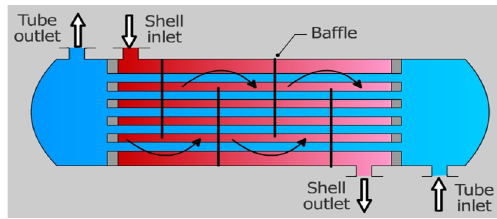
Figure 3. Shell and Tube Heat